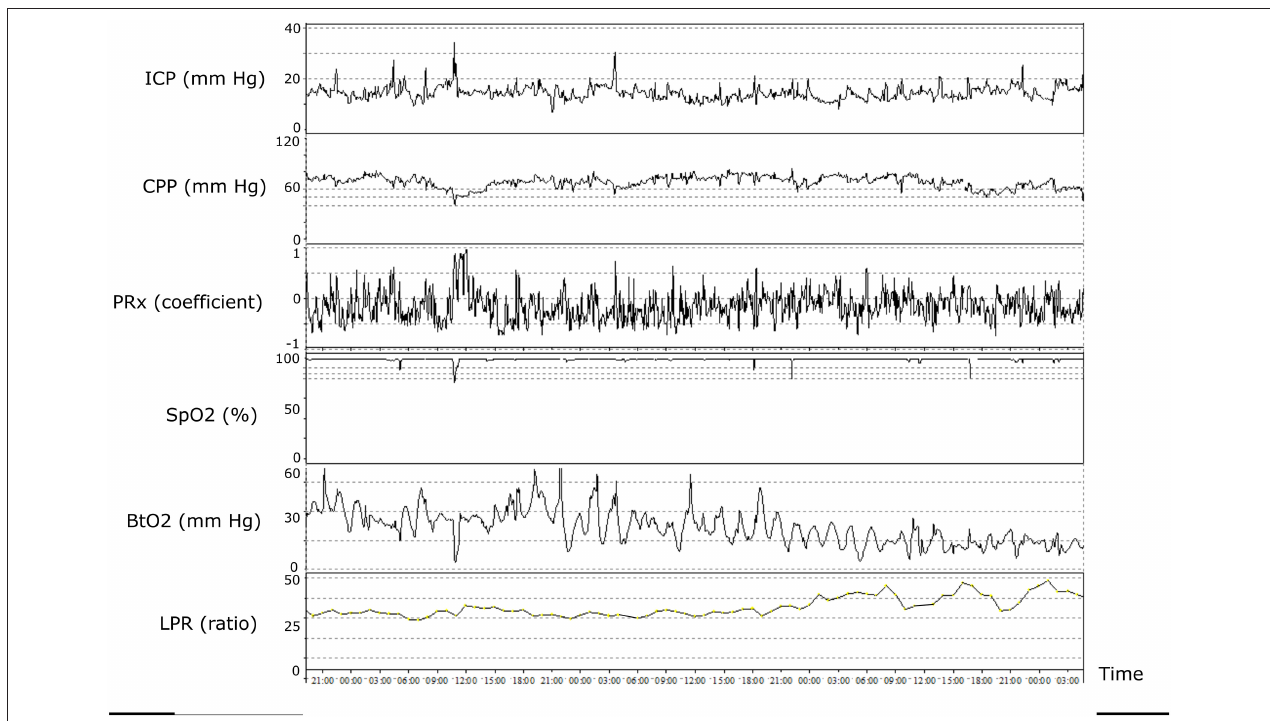
FIGURE 4 | Illustrative patient case with multimodal monitoring. The figure demonstrates the temporal evolution of cerebral physiology over ∼ 2 days. Although intracranial pressure (ICP), cerebral perfusion pressure (CPP), pressure reactivity index (PRx), and oxygen saturation (SpO 2 ) were within adequate intervals, the patient developed brain tissue hypoxia and cerebral energy failure (high lactate/pyruvate ratio). The pathophysiology may include microvascular thrombosis and/or increased diffusion limitations from cerebral